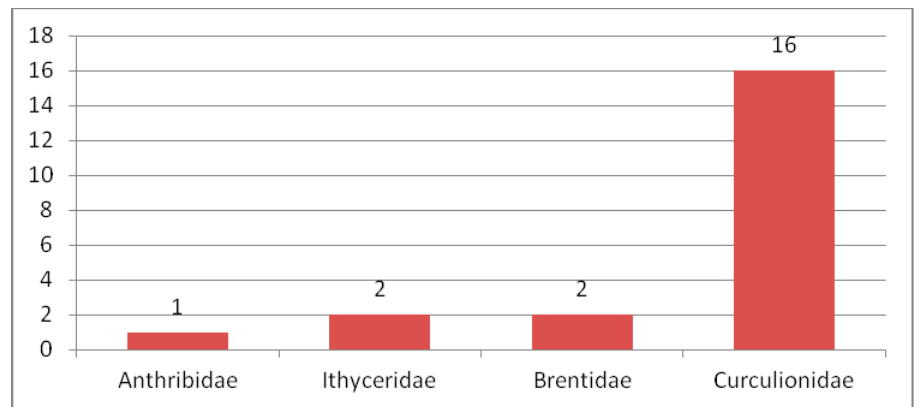
Figure 7. Composition of species of Curculionoidea in the Early Eocene fauna.